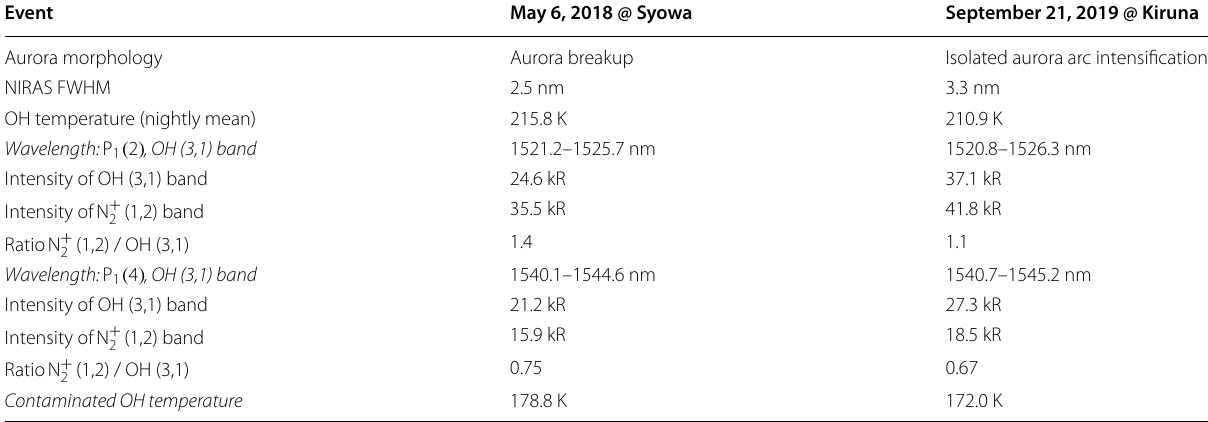
Table 3 A summary of spectral characteristics of OH (3,1) and N + 2 (1,2) bands for the two aurora events observed by the NIRAS